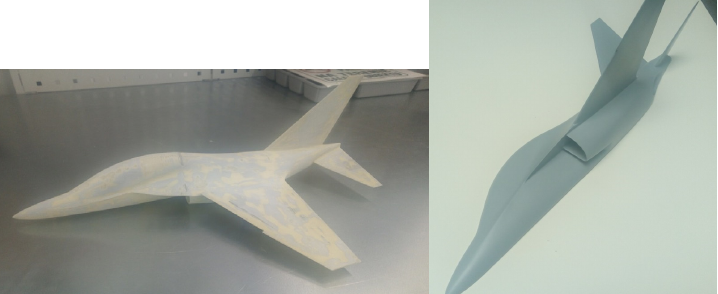
Figure 8. View of the model with the surface prepared for varnishing and after applying a layer of spray putty.